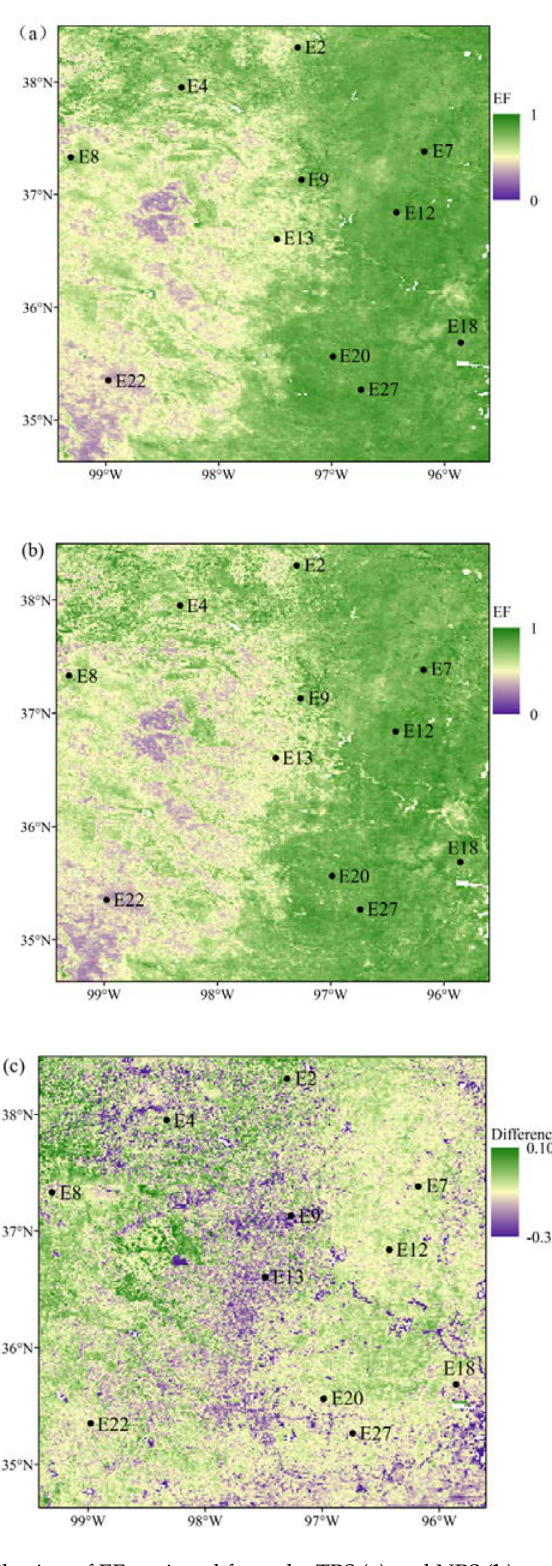
Figure 8. Spatial distribution of EF retrieved from the TPS ( a ) and NPS ( b ) as well as their differences ( c ) on DOY 239.